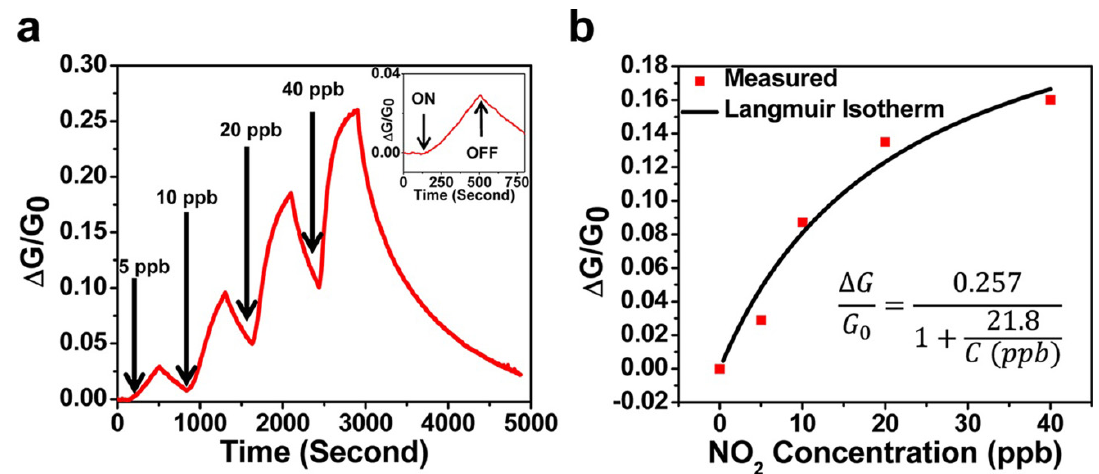
Figure 12. NO 2 gas sensing performance of multilayer BP FET. ( a ) Relative conductance change ( Δ G/G 0 ) vs. time in seconds for a multilayer BP sensor. Inset shows a zoomed in image of a 5 ppb NO 2 exposure response with identification of points in time where the NO 2 gas is switched on and off; ( b ) Δ G/G 0 plotted vs. NO 2 concentration applied to the BP FET showing an agreement between the measured values (red squares) and the fitted Langmuir isotherm. Reprinted with permission from Ref. [93]. Copyright, 2015, American Chemical